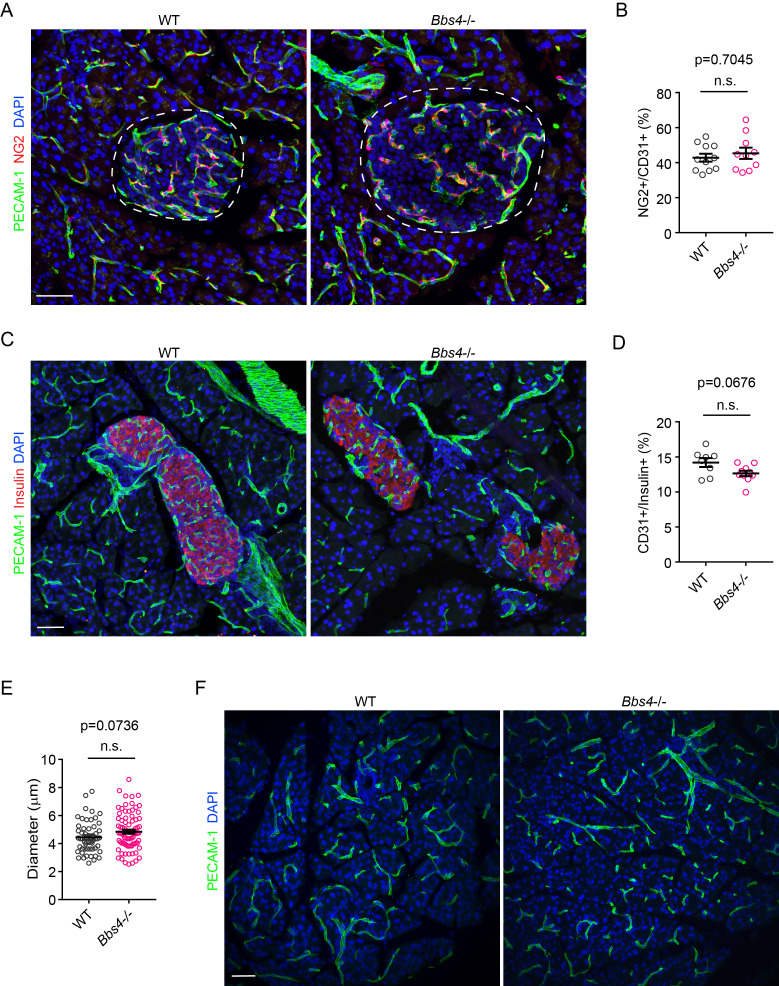
Pericyte coverage of intra-islet capillaries and capillary density in exocrine pancreas are not affected in Bbs4-/- mice.(A) Immuno-fluorescence staining of pancreatic sections from 2-month-old wt and Bbs4-/- animals showing pericyte coverage (NG2, red) on intra-islet capillaries (PECAM-1, green). (B) Quantification of surface ratio of NG2 positive area to PECAM-1 positive area. n = 4 for animals and n = 2–4 islets per animal. (C) Immuno-fluorescence staining of pancreatic sections from 4-month-old wt and Bbs4-/- animals showing islets (insulin, red) and intra-islet capillaries (PECAM-1, green). (D–E) Quantification of relative intra-islet PECAM-1 positive volume, normalized to insulin-positive volume (D) and average intra-islet capillary diameters (E) in wt and Bbs4-/- islets from 4-month-old animals. n = 4 for animals and n = 2–4 islets per animal. (F) Immuno-fluorescence staining of pancreatic sections from 2-month-old wt and Bbs4-/- animals, showing PECAM-1 (green) labeled capillaries in exocrine pancreas. Individual data points are shown, n.s. means not significant by Mann-Whitney test. Scale bars: 50 μm.